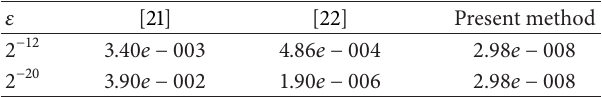
Table 1: Comparison of maximum absolute error with other methods for 𝑁 = 64 .